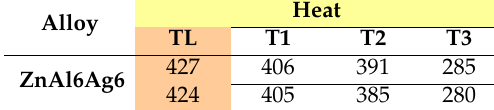
Table 3. The temperatures of phase transformation under heating in accordance with DSC/DTA analysis.